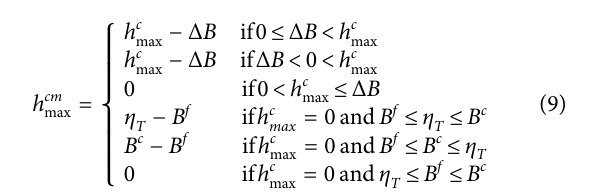
Frontiers in Earth Science |